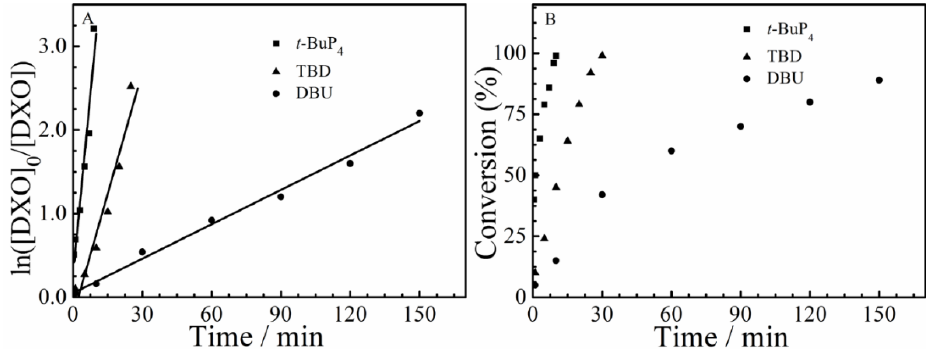
Figure 4. ( A ) Kinetic plots ([DXO] 0 / [I] 0 = 50 / 1) and ( B ) dependence of monomer conversion on reaction time for the ROP of DXO with t -BuP 4 (square), TBD (triangle) and DBU (circle) as catalysts.